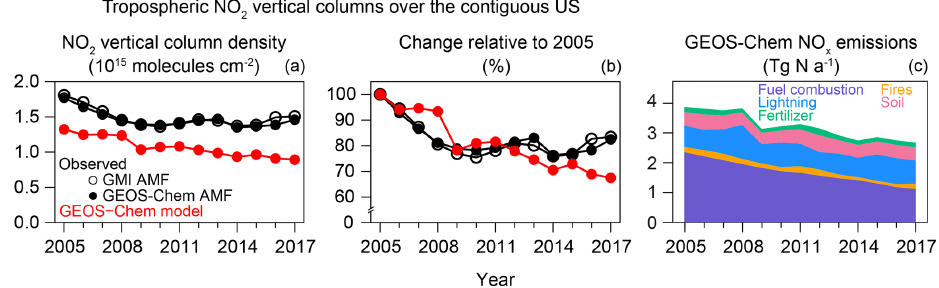
Figure 1. The 2005–2017 trends in tropospheric NO 2 columns and NO x emissions over the contiguous US. Panel (a) shows OMI observa- tions averaged over the contiguous US and the corresponding GEOS-Chem simulation. The OMI observations are from the NASA retrieval (Krotkov et al., 2017) with air mass factors (AMFs) computed from the original GMI model NO 2 vertical profiles or GEOS-Chem vertical profiles. Panel (b) shows percent changes in tropospheric NO 2 columns relative to 2005. Panel (c) shows 2005–2017 annual total NO x emissions from the GEOS-Chem model, including anthropogenic fuel combustion emissions from the National Emission Inventory (NEI), with a 60% decrease for non-EGU sources (see text and